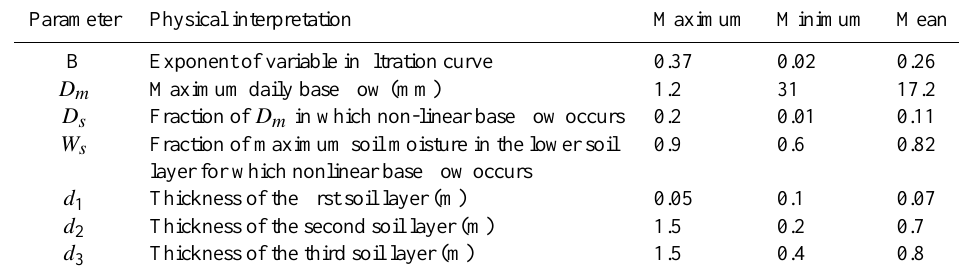
Table 2. Statistical features of the VIC model parameters for 125 calibrated catchments.